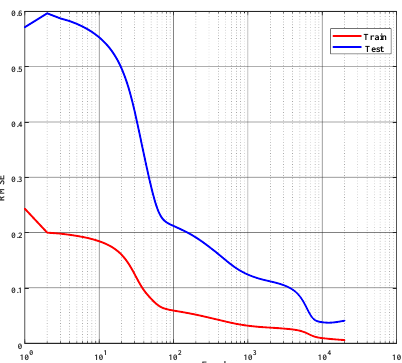
Figure 11. Architecture of ANN which was used for the modeling of cell viability and LDH activity.